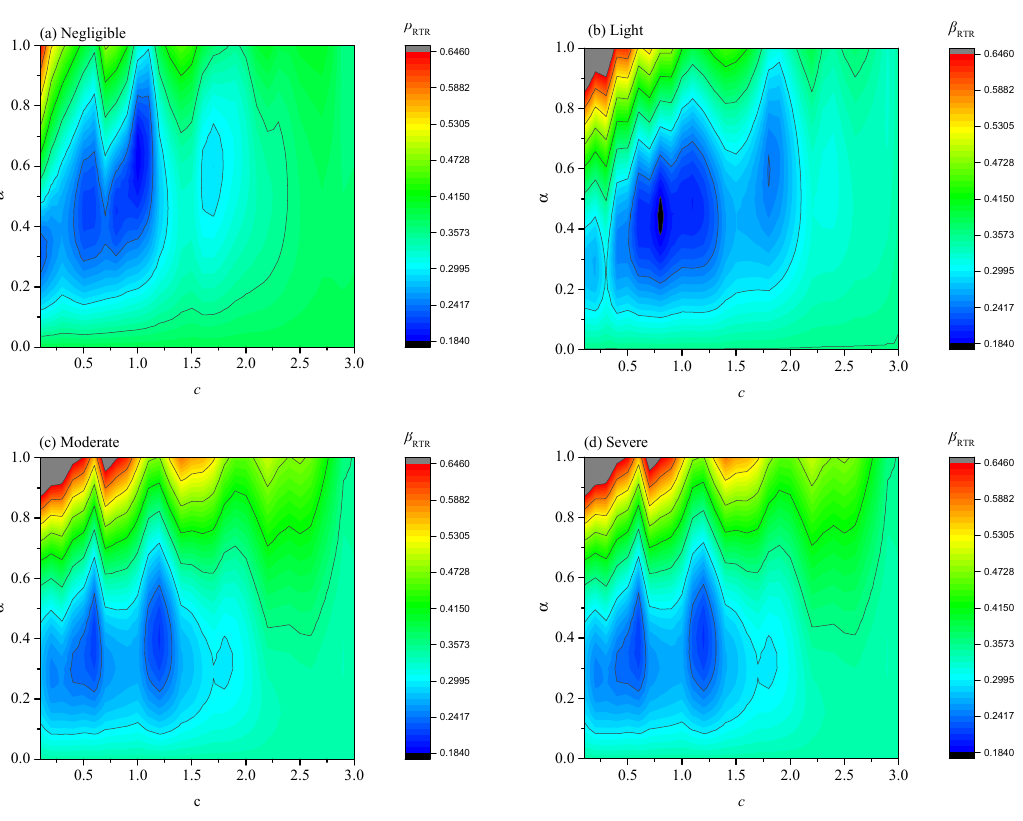
Figure 14. β RTR obtained using IM ∗